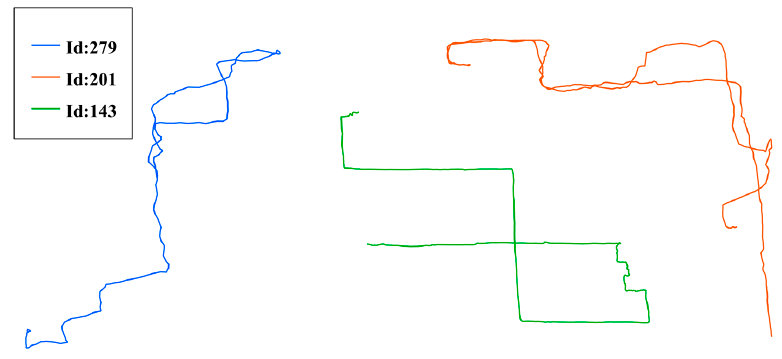
Figure 4. Self-intersecting trajectories from the Geolife dataset.